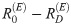
The modulatory effect of asynchronous release dynamics on synaptic information efficacy during short-term depression.(A) Relative difference between the mutual information rates of the release site with and without depression, as a function of depression multiplier, d, and release probability, q0, of asynchronous release. For the synchronous spike-evoked release, the dynamics is kept fixed at c = 0.5 and p0 = 0.7. The black line shows the boundary between positive and negative values. (B) Relative difference between the energy-normalized information rates of the release site with and without depression. (C) Three functional categories of the release site during depression. (D) Changes in the mutual information rate (solid lines), R0−RD, and energy-normalized information rate (dashed lines), R0(E)-RD(E), during depression. The functions are plotted against asynchronous release probability, q0, for different values of depression multiplier, d. (E) The impact of similar depression dynamics for asynchronous and synchronous spike-evoked release (c = d) on the rate changes during depression. We simulate R0 − RD and R0(E)-RD(E) as a function of input spike rate, α, for different values of depression multiplier. For the simulations in this figure, the recovery time constants are fixed at e = f = 0.1.